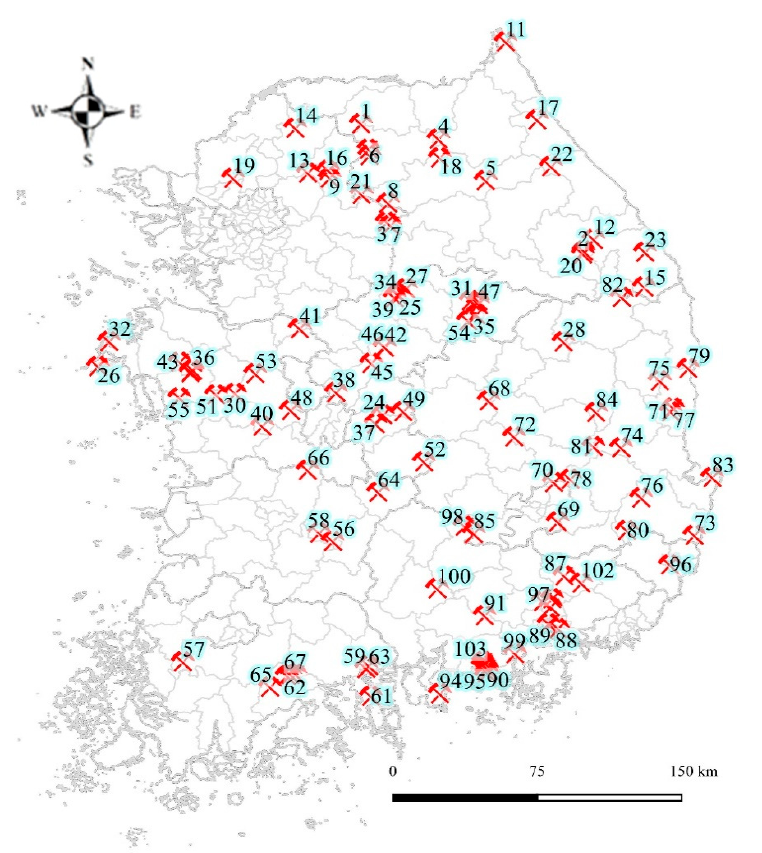
Figure 1. Locations of the 103 abandoned metal mine areas.